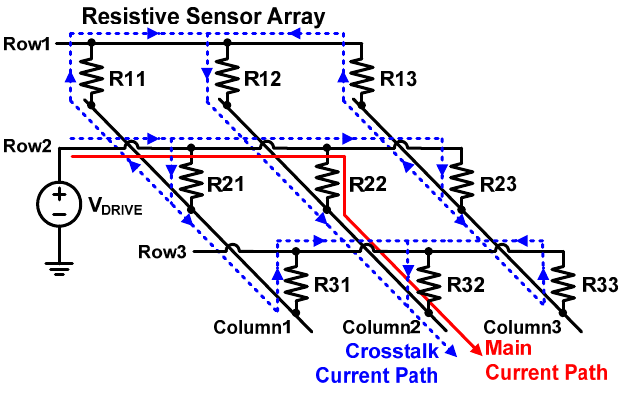
Figure 1. Crosstalk current paths in a resistive sensor array.